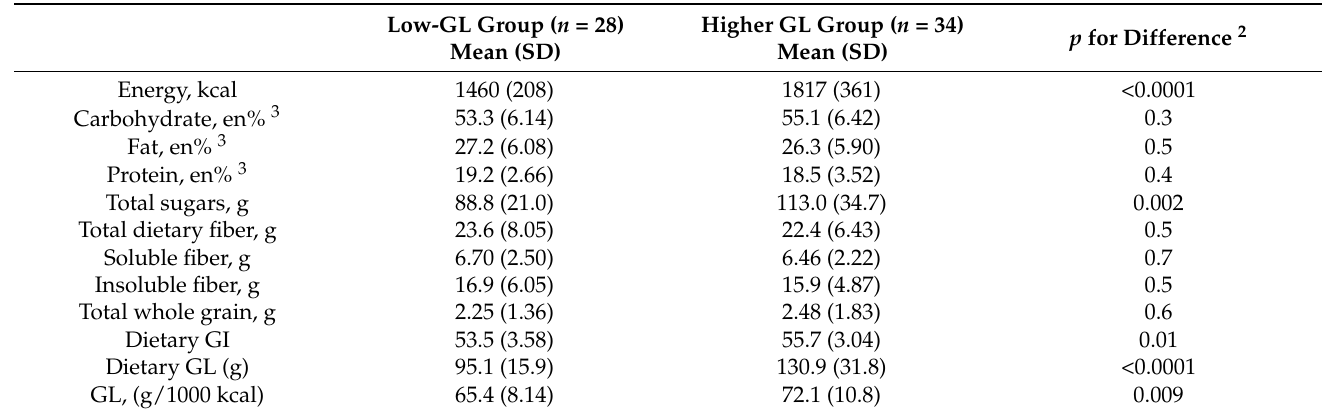
Table 2. Participants’ dietary intake by intervention group 1.